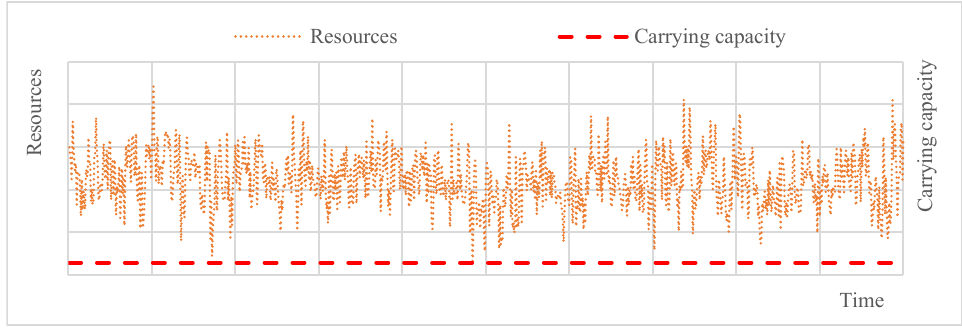
Figure 4. Toy model: The concept of environmental determinism with HK dynamics adding a technological step. Red dash line shows the carrying capacity of the resources.